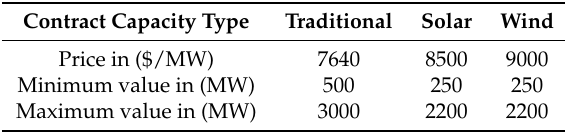
Table 1. Assumed contract capacity prices and